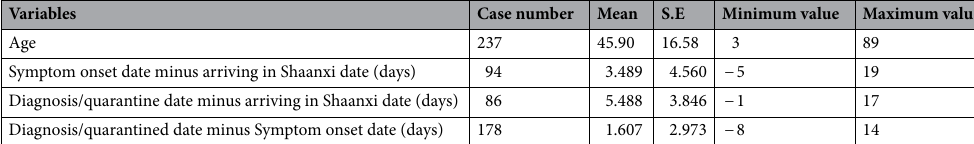
Variables Case number Mean